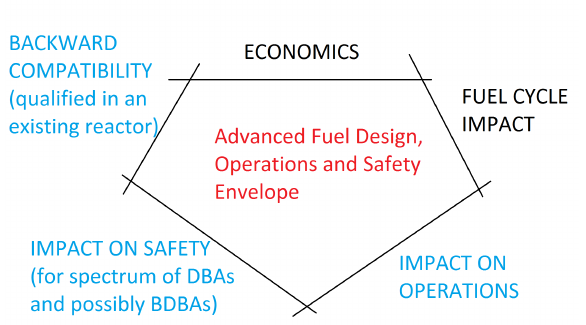
Figure 3. Constraints on New Fuel